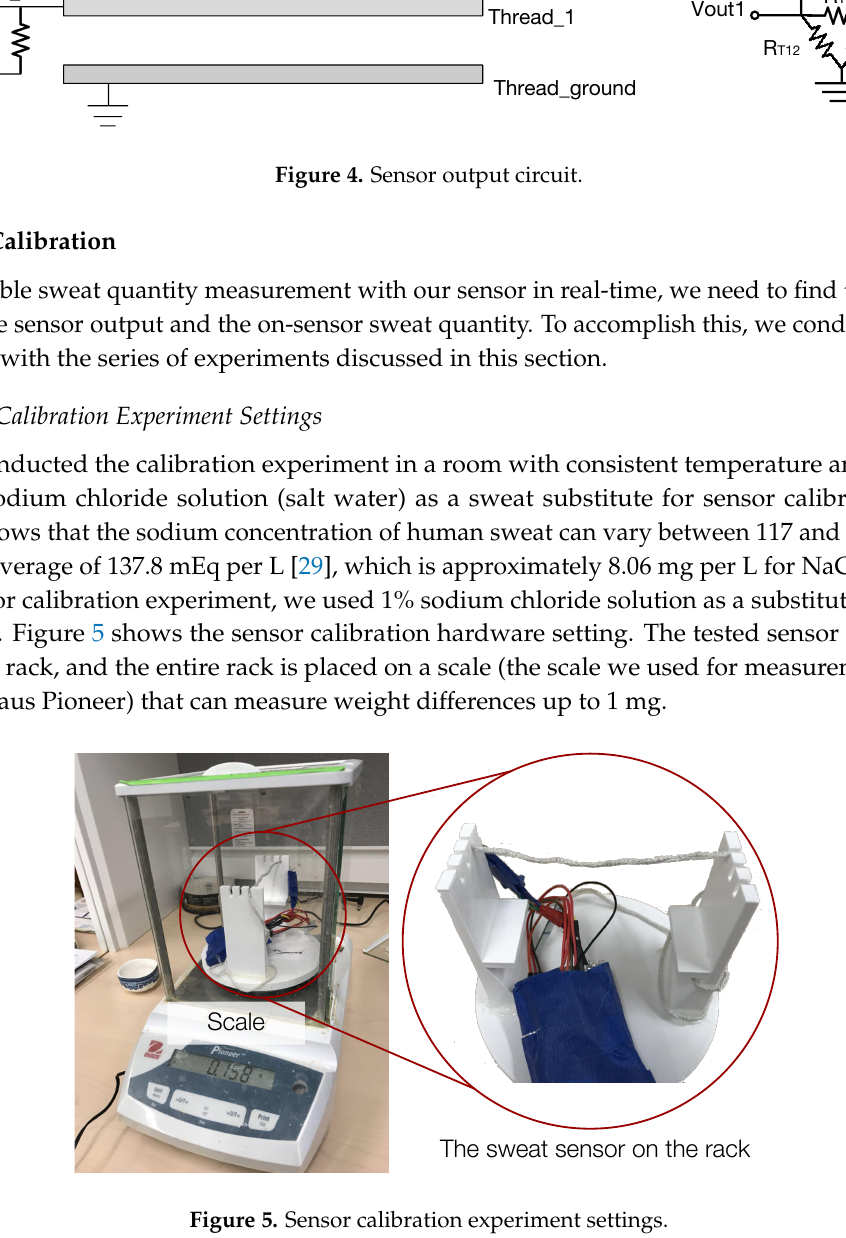
Figure 5. Sensor calibration experiment